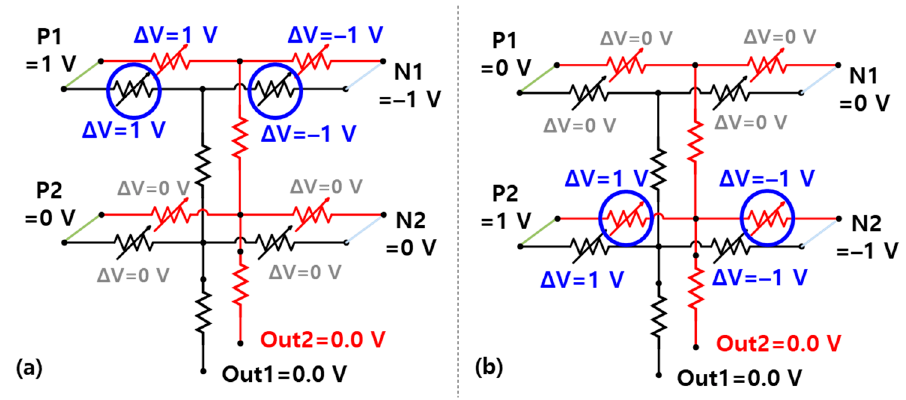
Figure 8. Simplified circuit diagrams of 3D vertical synapse during the testing procedure showing the test voltages applied to ( a ) the Out1 neuron and ( b ) the Out2 neuron.